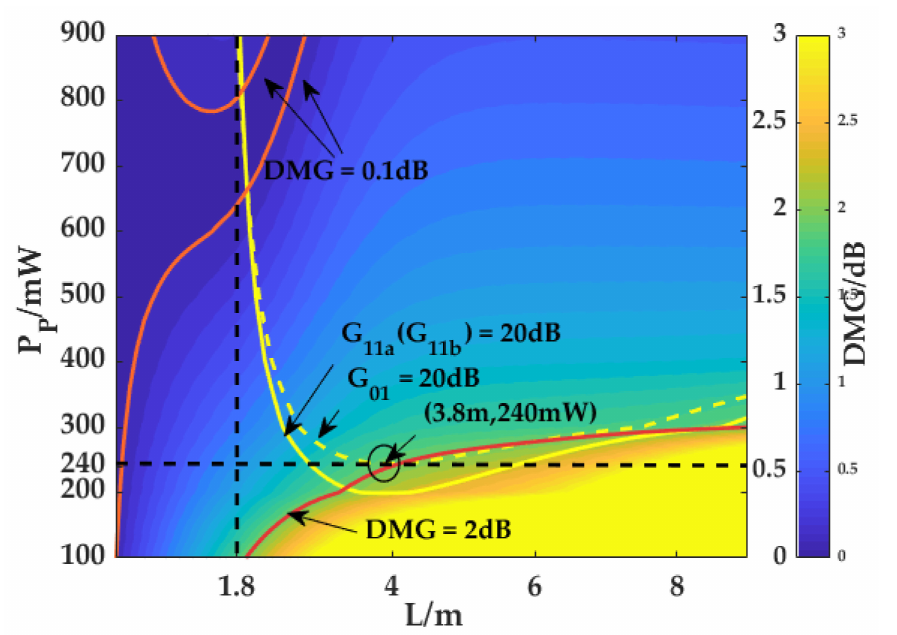
Figure 5. The structure of the VPI simulation system.